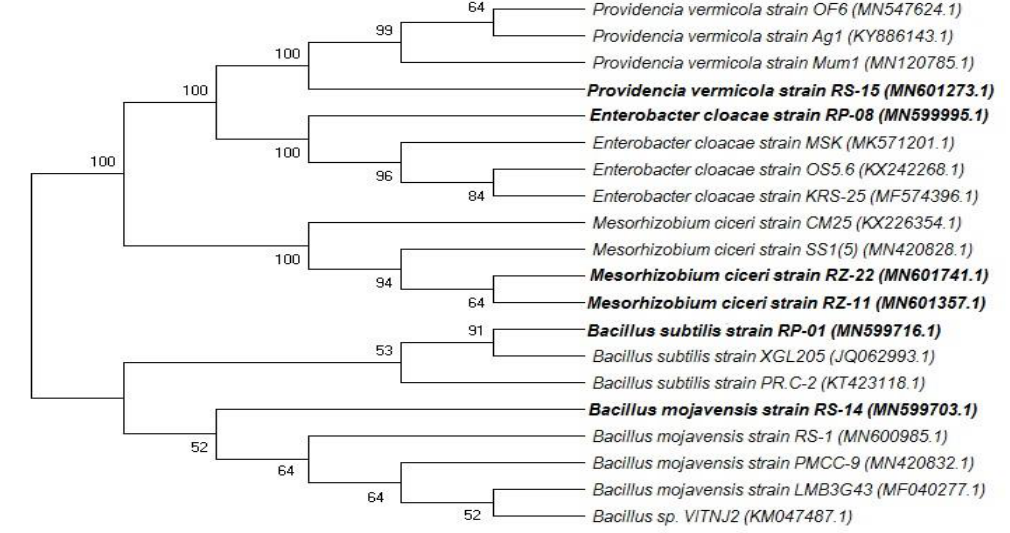
Figure 1. Phylogenetic tree showing the screened isolates given in bold letters and closest homologues. Bootstrap values ( n = 100) are displayed at the nodes.